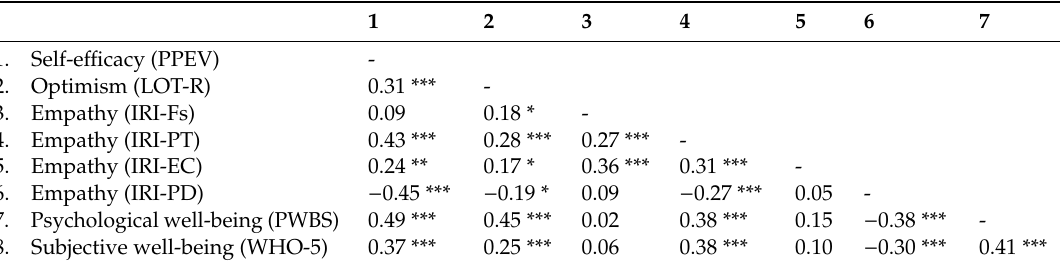
Table A1. Pearson’s correlations between the study psychological